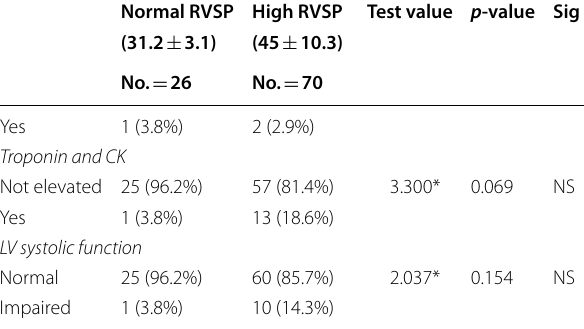
Table 5 Comparison between patients with normal and